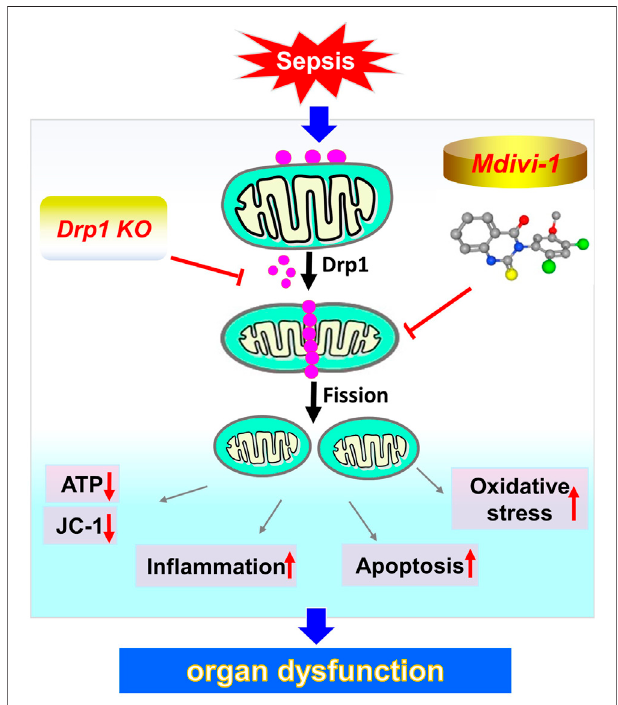
FIGURE 7 | Schematic depiction of the potential protective effect of inhibition of mitochondrial fi ssion during sepsis.